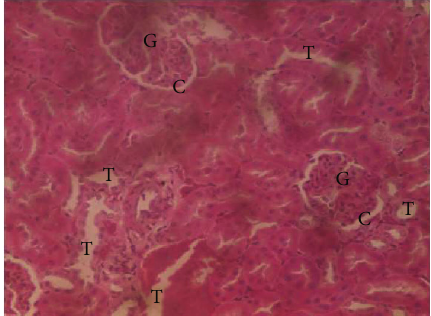
Figure 11: Photomicrographs of the group V rats showing normal kidney.